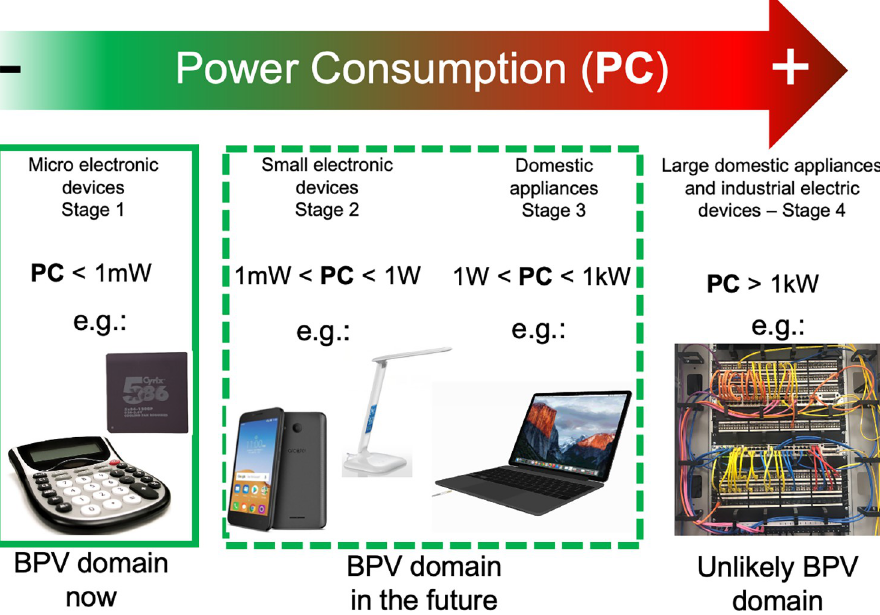
Fig 1. Present and future domains for applications of BPV. The figure suggests a range of applications, from those which could be powered by BPV at present (Stage 1, left), through to applications for which powering by BPV, even in the future, is unlikely (Stage 4,